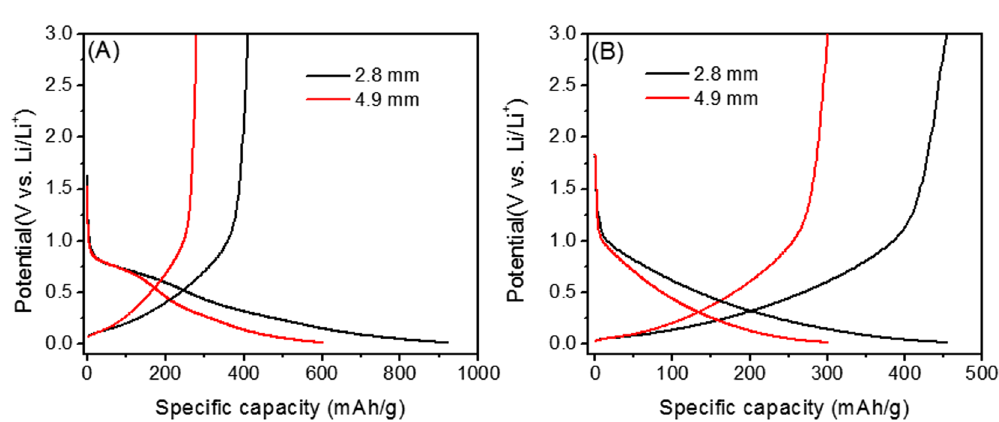
Figure 4. ( A ) Galvanostatic charge-discharge tests at a current density of 0.1 A/g (0.5 C); ( B ) Rate capability of the ECF electrode with a thickness of 13.7 mm at different current densities; ( C ) Subsequent cycling tests at 0.1 A/g (0.5 C) from 60 th to 300 th cycle.